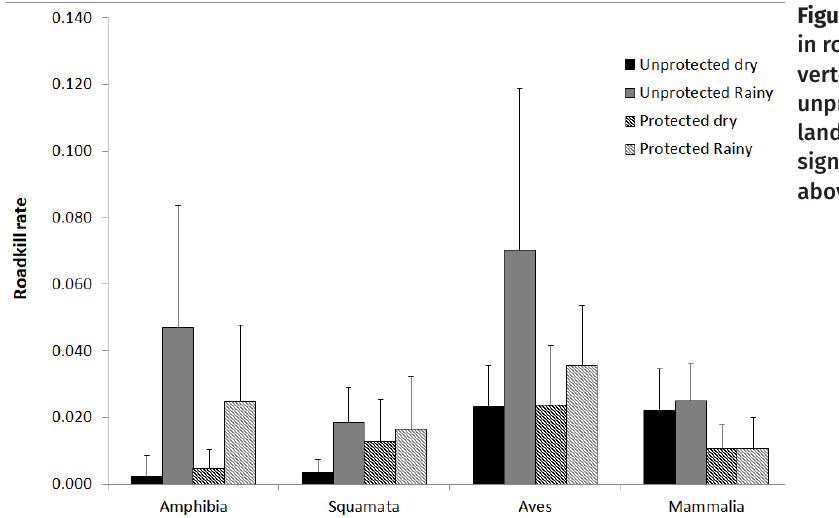
Figure 4. Seasonal variation in roadkill rates for each wild vertebrate group both in the unprotected and the protected landscapes. Errors at a 5% significance level are presented above bars.